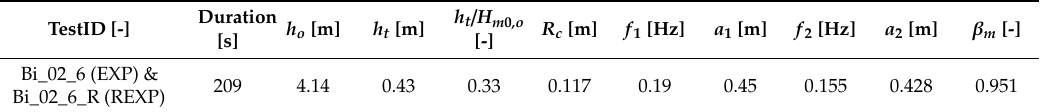
Table 1. Hydraulic parameters for the WALOWA bichromatic wave test (EXP) and its repetition (REXP): h o is the offshore water depth, h t the water depth at the dike toe, H m0,o the incident offshore significant wave height, R c the dike crest freeboard, f i the SW component frequency, a i the SW component amplitude, and β m (= a 2 / a 1 ) the modulation factor.